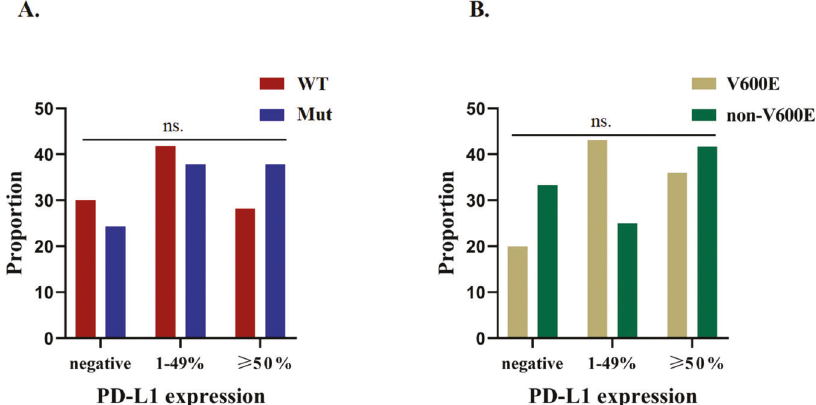
Fig. 5 PD-L1 expression of patients according to BRAF mutation status and BRAF mutation type. A PD-L1 expression were evaluated in BRAF mutant and wild-type group. B PD-L1 expression were evaluated in BRAF V600E and Non-V600E